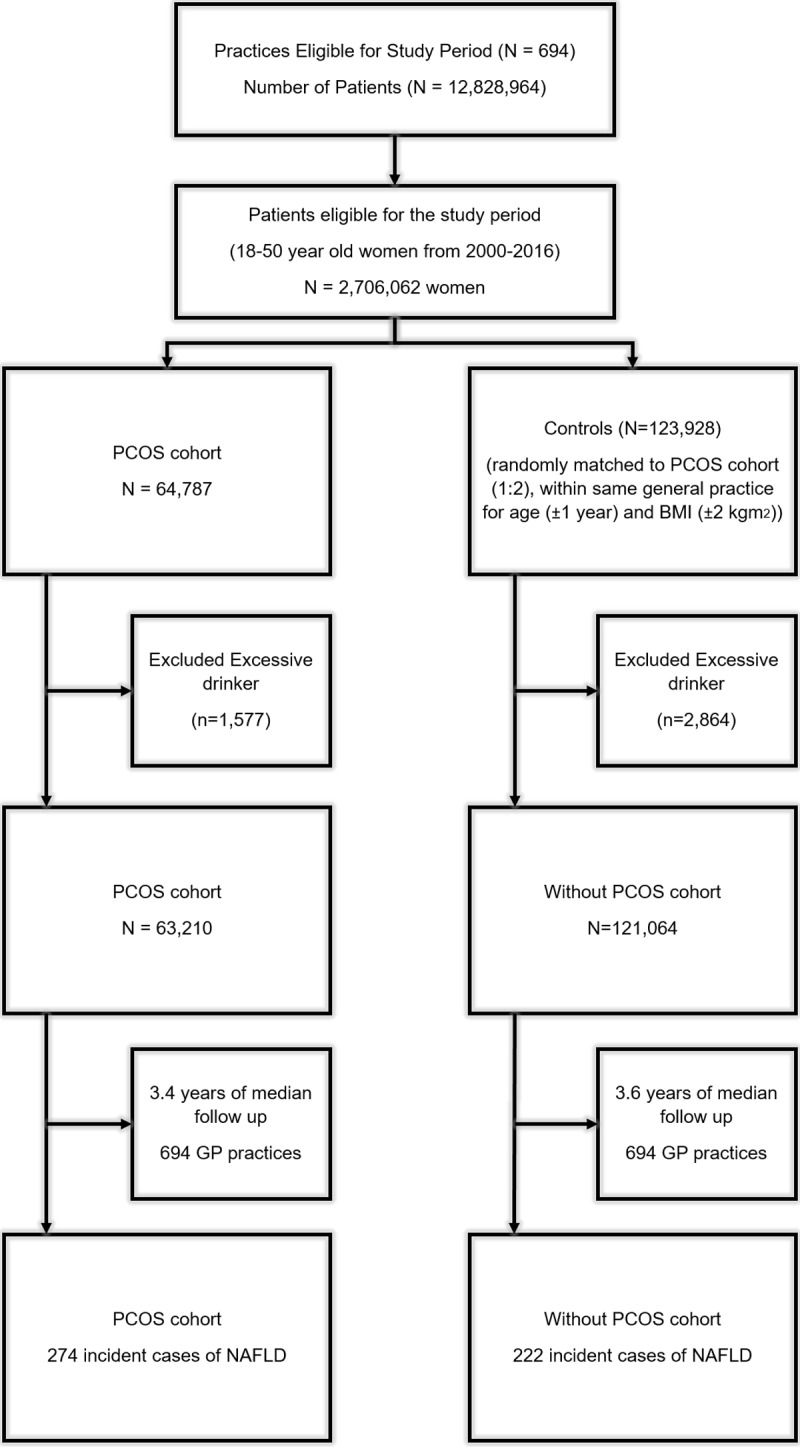
Selection of patients with polycystic ovary syndrome (PCOS) and controls.A total of 694 general practices were eligible for inclusion in the study, with a total of 2,706,062 women for the study period 2000–2016. A total of 64,787 women were listed as having PCOS according to the criteria defined in the “Methods” section. Controls were randomly matched to women with PCOS at a ratio of 2:1 within each practice, generating a random control cohort of 123,928 women. Participants with a documented history of alcohol excess were excluded; therefore, the final cohort consisted of 63,120 women with PCOS and 121,064 controls.